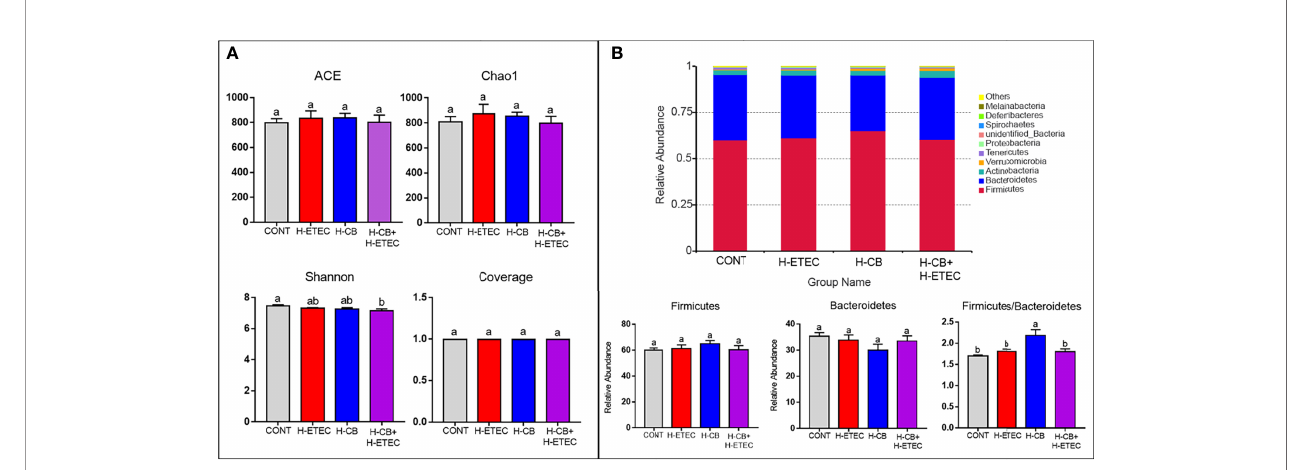
FIGURE 6 | Effects of CB and/or ETEC K88 on the cecal microbial community structure. (A) Alpha diversity of cecal microbiota in mice (n = 3 mice per group). (B) Relative abundance of cecal microbiota of mice in different groups at the phylum level (n = 3 mice per group). Values shown are the means ± SEM. Different small letters indicate signi fi cant differences ( p <